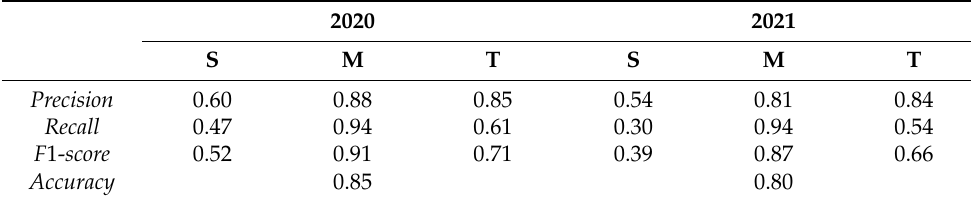
Table 4. Model performance of DenseNet121 in 2020 and 2021.